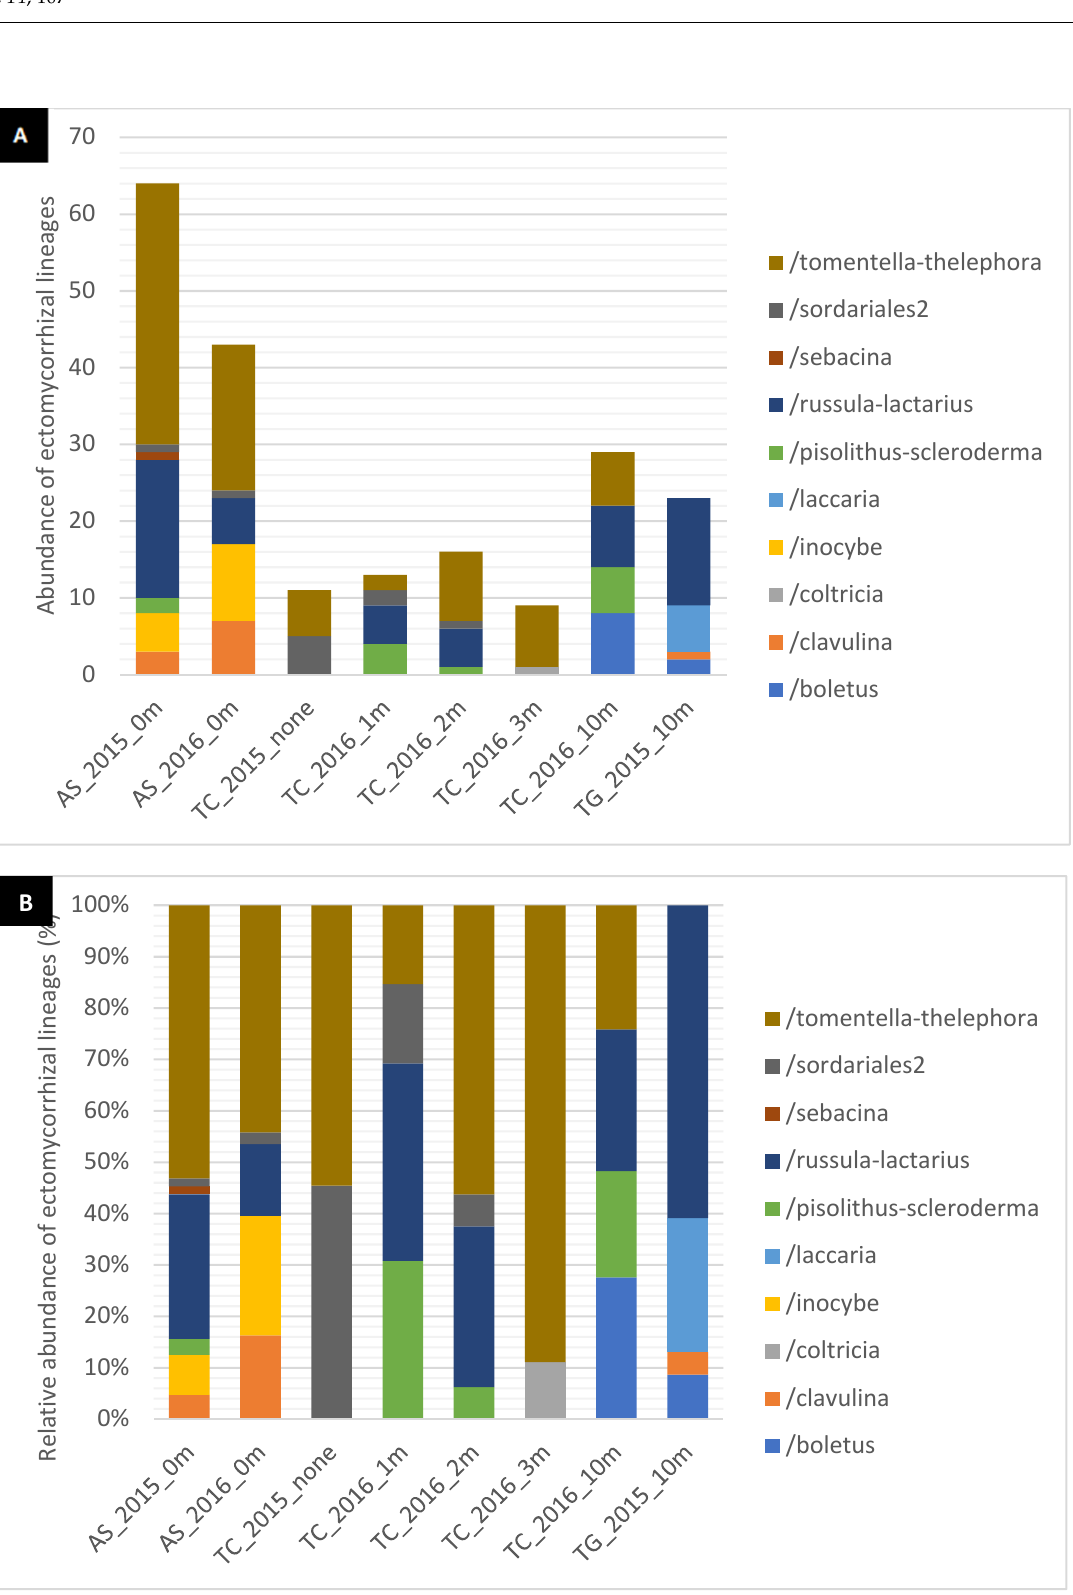
Figure 4. Ectomycorrhizal lineages found in nurse trees ( A . spirorbis = AS) and target plants ( T . calobuxus = TC) at successive distances (1, 2, 3 and 10 m away from A . spirorbis ) after one year of plantation. Bar name corresponds to the plant (AS or TC), the year of sampling (2016) and the minimum distance of sampling from AS (0 m for AS; 1, 2, 3 and 10 m for TC; more than 10 m for TG). Data are presented according to the true abundance of lineages ( A ), and relative abundance expressed in % ( B ). Table 1. Ecological diversity indexes of the ECM fungal OTUs according to all treatments. The names of the treatments include the host species (AS: A . spirorbis ; TG: T . guillainii ; TC: T . calobuxus ), the year of sampling (2015 or 2016) and the distance of sampling from A . spirorbis , expressed in